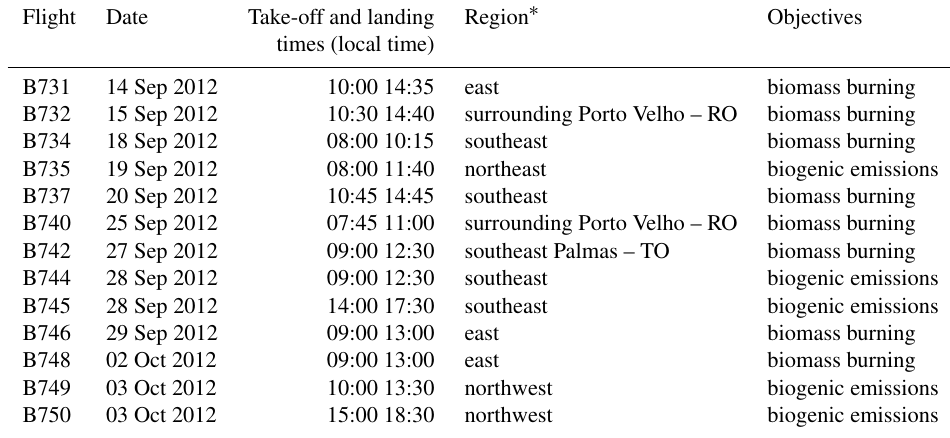
Table 1. SAMBBA research flights analyzed in this work. Reference locations indicated in the map of the Fig. 2. Flight Date Take-off and landing Region ∗